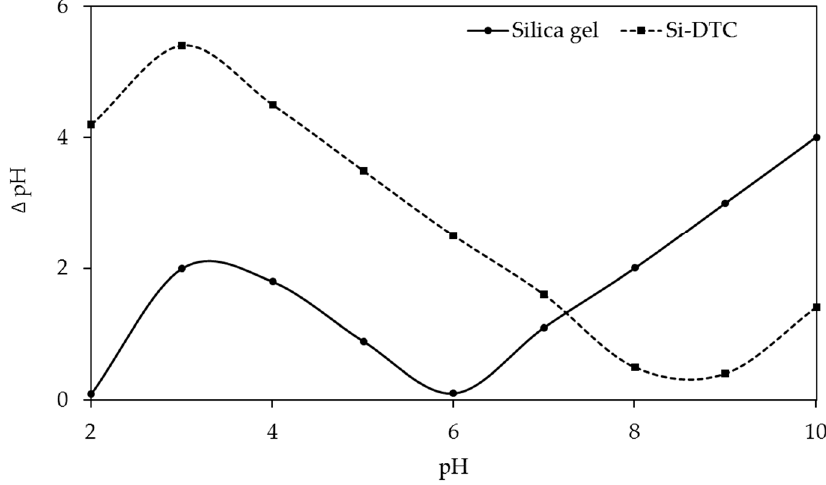
Figure 3. Determination of pH PZC.